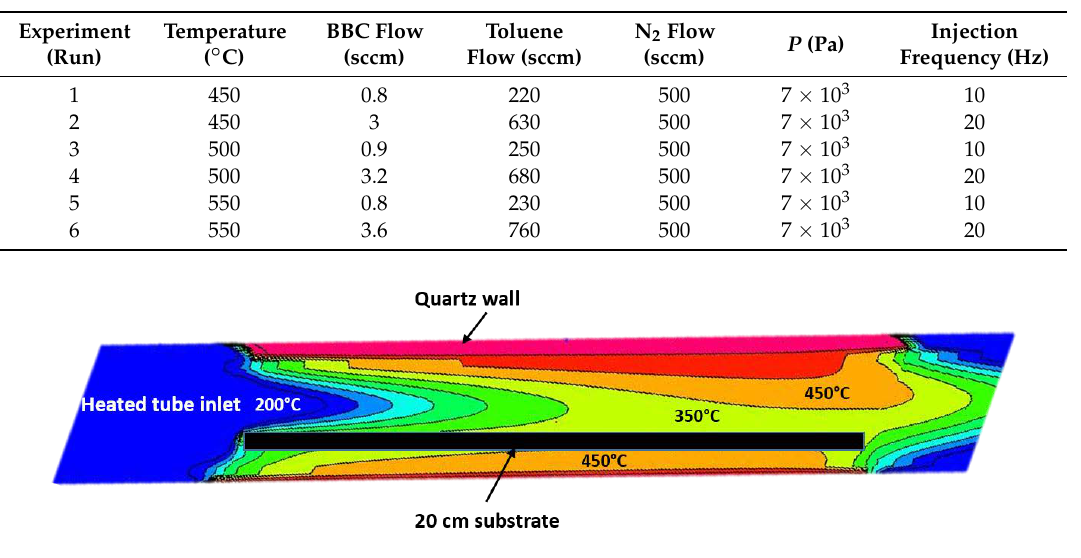
Table 4. Operating conditions used for modeling.